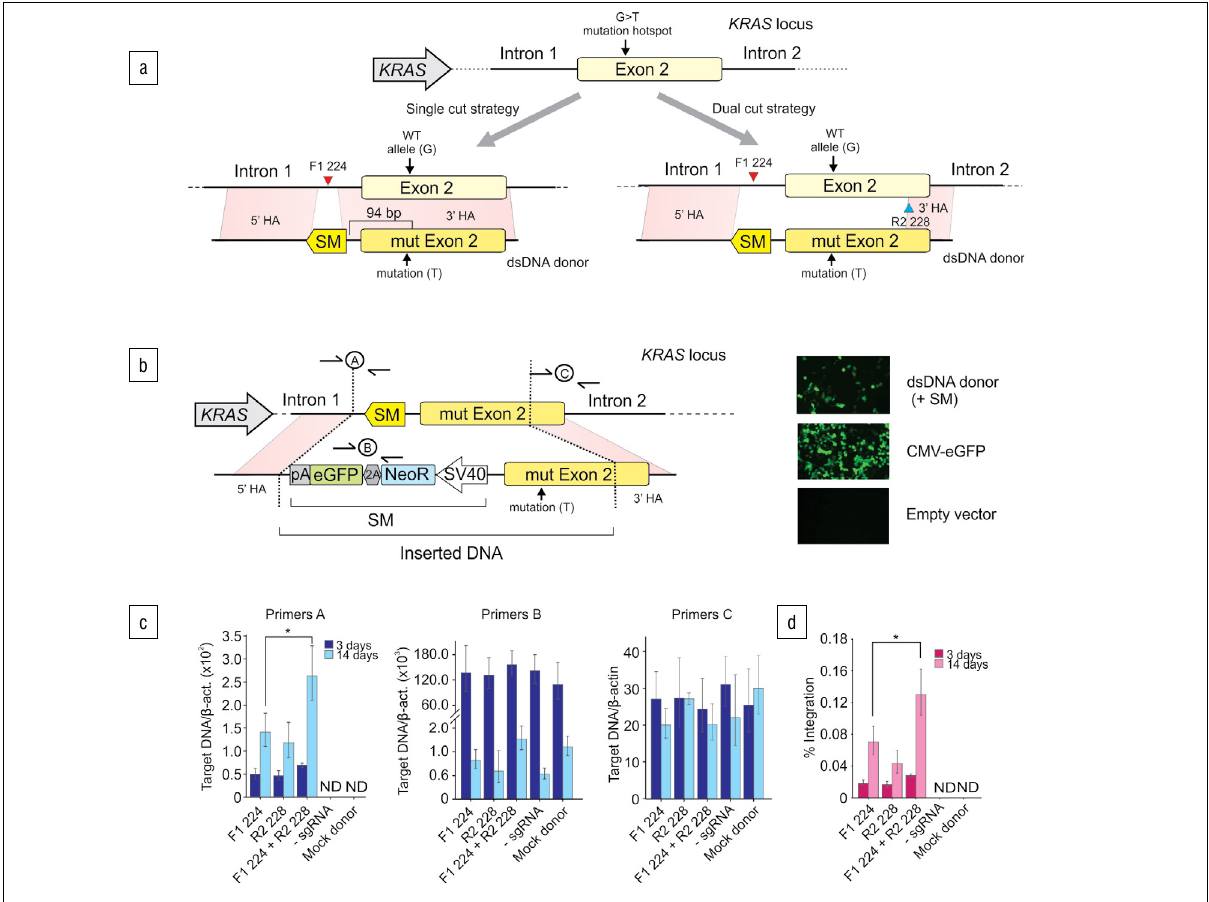
The envisioned dual cut strategy versus the traditional single cut strategy to modify the KRAS gene. (a) The extent of gene conversion is limited with the traditional single cut strategy, which uses a dsDNA donor design that has two homology arms (HAs) that directly flank the DSB site. The successful co-transfer of both the gene mutation and the selection marker cassette (SM) into sites that are 94 bp apart will be very inefficient with a single cut, as a result of short gene conversion tracts. The dual cut strategy should overcome this inefficiency by deleting the entire region between the two sites and then reconstituting this region with a modified gene sequence that contains the mutation and the selection marker. (b) The dsDNA donor was designed to functionally separate the intended gene modification elements (the selection cassette and the point mutation) from the homology arms. This separation ensured that the homology arms maintained complete homology with the target sequence and functioned solely to direct the construct to the target region. The selection cassette was designed to be expressed in the opposite direction of KRAS gene transcription to produce a chimeric eGFP-NeoR protein that is cleaved by an embedded 2A self-cleaving peptide, allowing for a fluorescence or antibiotic-based approach for selection. Fluorescence micrographs showed the expression of eGFP in HEK293 cells that were transfected with this construct (right). A qPCR strategy was used to determine the integration efficiency of the dsDNA donor into the KRAS gene by measuring the amount of various DNA components (left). Quantification was done on extracted gDNA 3 and 14 days post-transfection. (c) Relative amounts of detected target DNA of each primer set, normalised to β -actin. (d) The percentage of KRAS alleles that successfully underwent integration of the selection cassette at the KRAS gene locus, as calculated by taking the data from primer set A (integration events) as a percentage of primer set C (total KRAS DNA) (mean±SD, ND denotes no detected